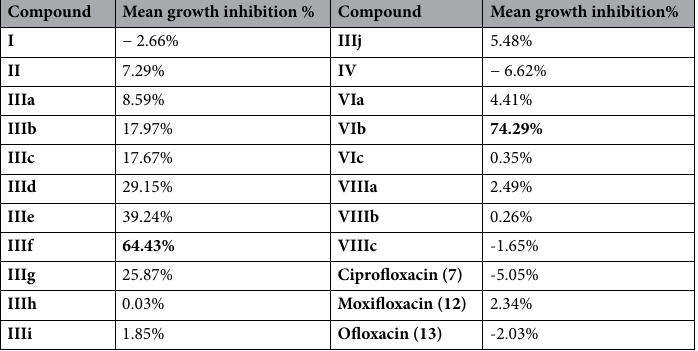
Table 1. Mean growth inhibition % of the tested derivatives in the single dose NCI-60 Human Tumor Cell Lines Screen at 10 µM. Significant values are in bold. Moxifloxacin (NSC:758875), ofloxacin (NSC: 758178), and ciprofloxacin (NSC: 758467) data were obtained from the NCI repository.